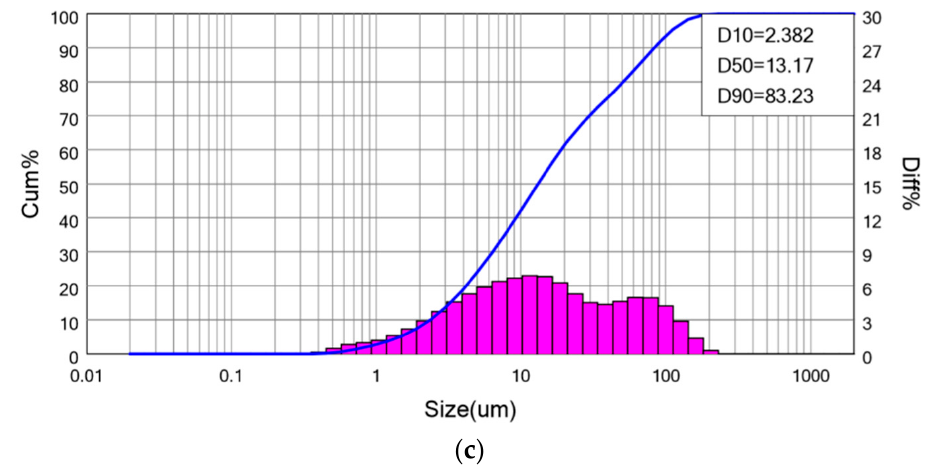
Figure 1. The particle size distribution curves of ( a ) Aggregate Sludge, ( b ) Fly Ash, and ( c ) Ground Granulated Blast Furnace Slag.